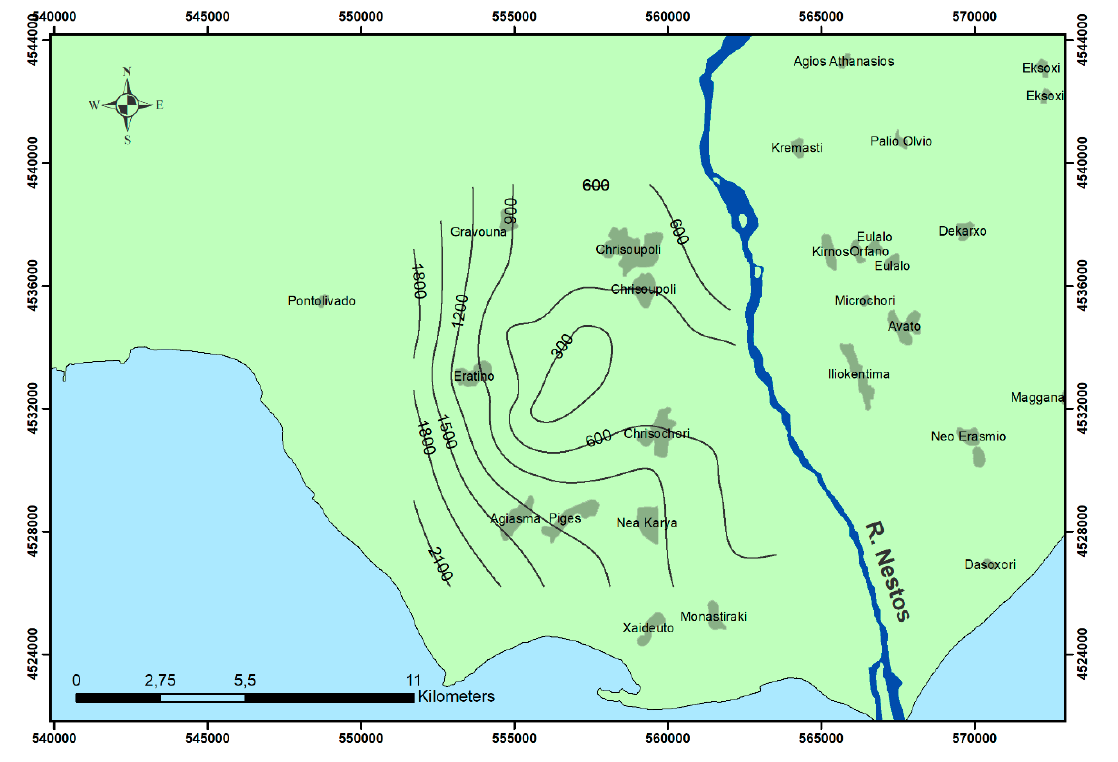
Figure 9. Electrical conductivity distribution map ( μ S/cm) of the unconfined aquifer (May 2019).